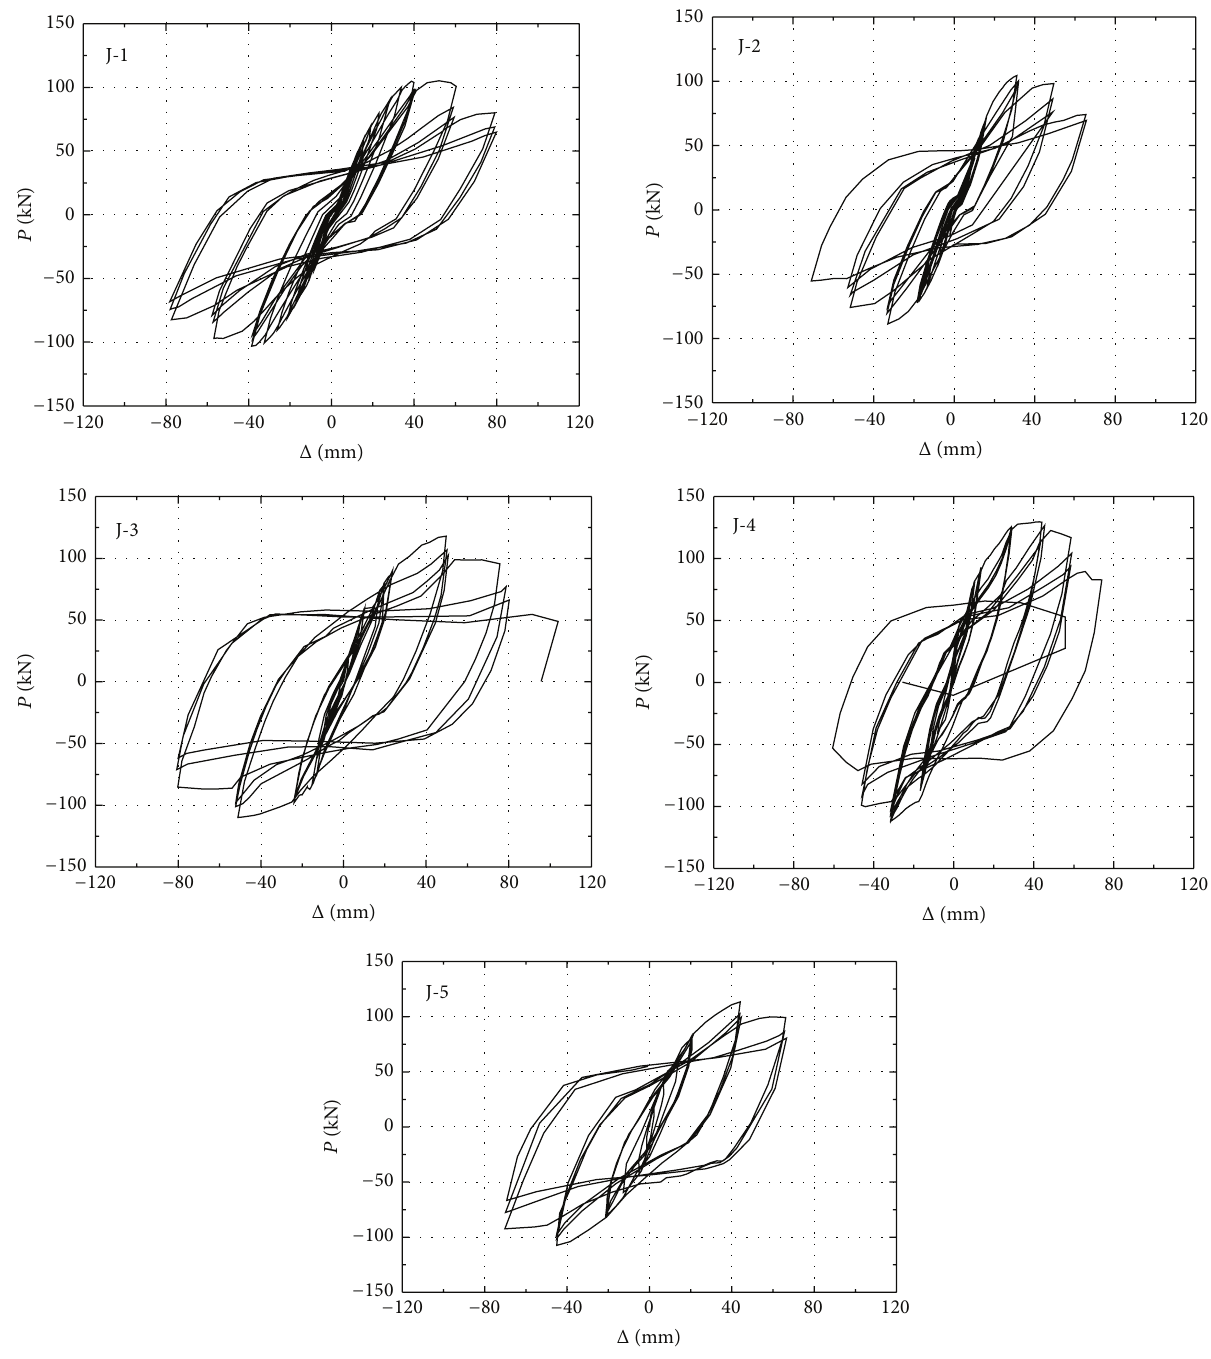
Figure 19: Hysteresis loops of